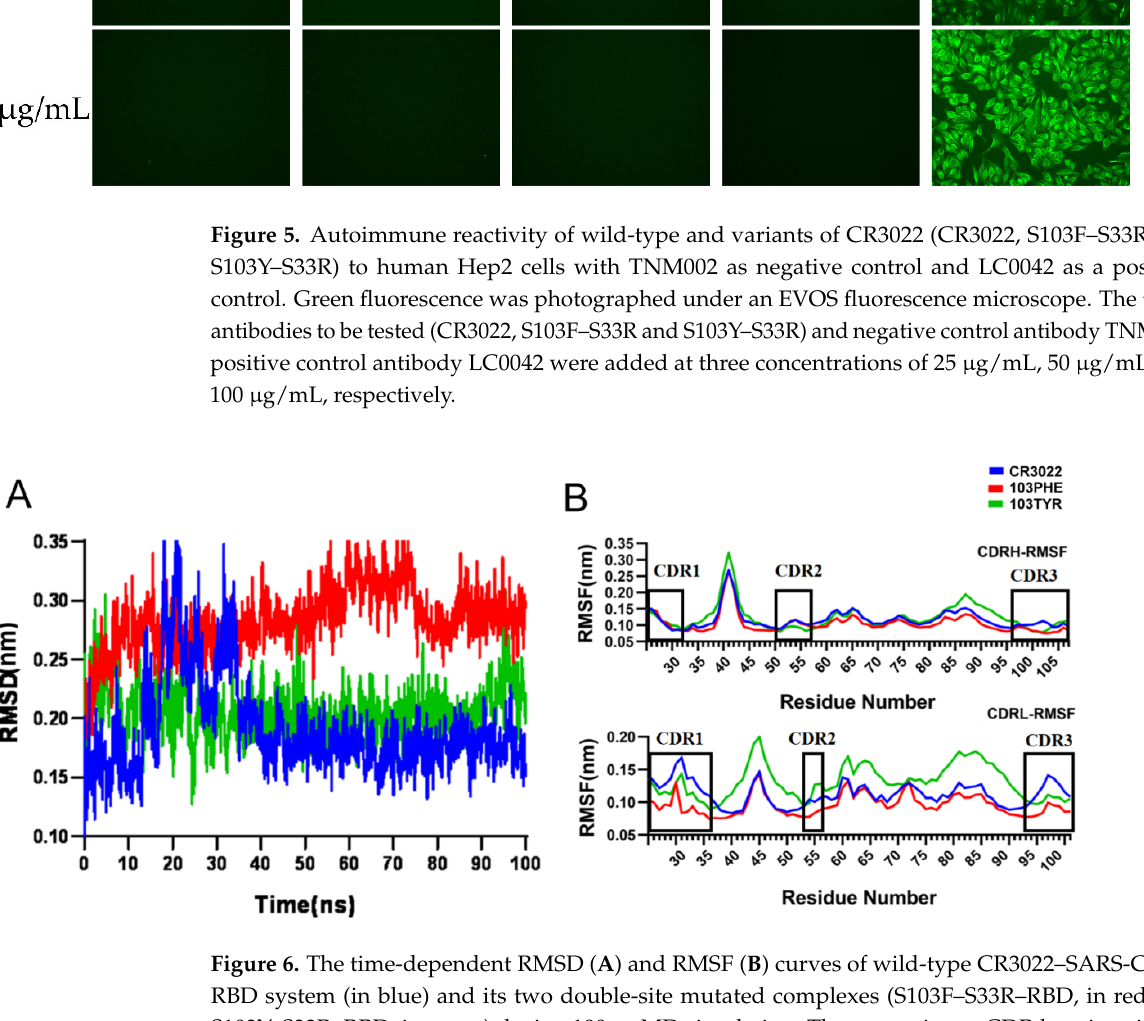
Figure 6. The time-dependent RMSD ( A ) and RMSF ( B ) curves of wild-type CR3022–SARS-CoV-2 RBD system (in blue) and its two double-site mutated complexes (S103F–S33R–RBD, in red and S103Y–S33R–RBD, in green) during 100 ns MD simulation. The approximate CDR locations in the heavy and light chain (CDR1, CDR2 and CDR3) with IMGT number were respectively marked with a black frame.